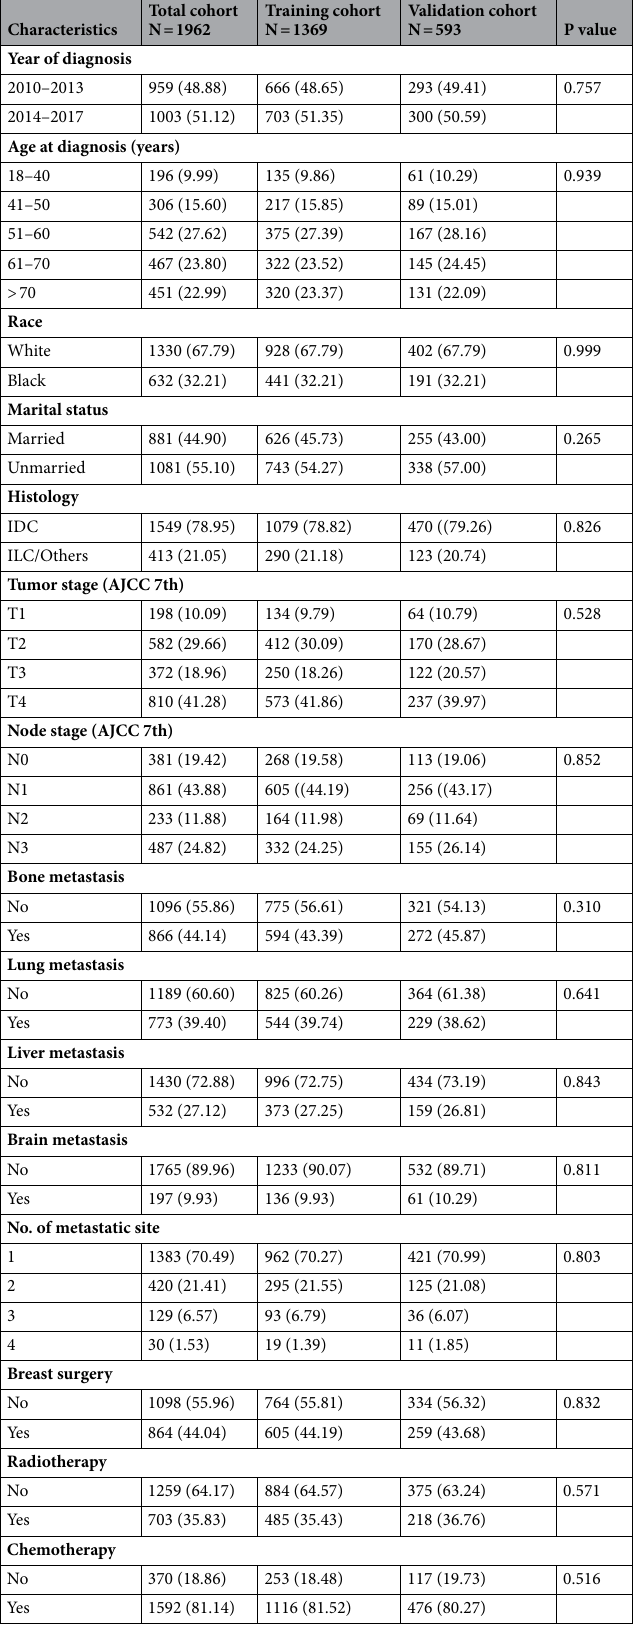
Table 1. Clinicopathological characteristics of metastatic TNBC in the training and validation cohorts. IDC infiltrating ductal carcinoma, ILC infiltrating lobular carcinoma, AJCC American Joint Committee on